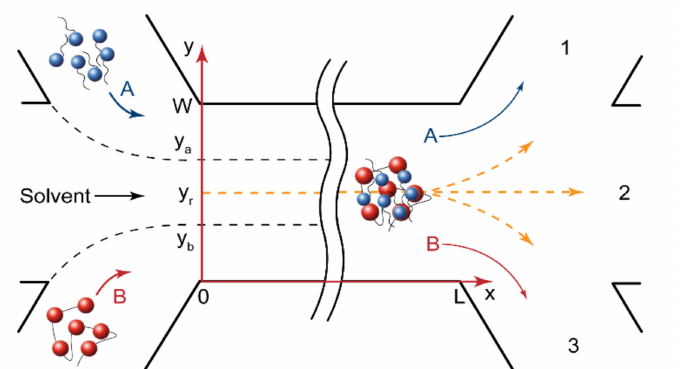
Figure 2. Geometry of microfluidic devices. The reagents were fed through the side input channels, the solvent was fed through the central input channel to avoid an immediate mixing of reagents and the start of reaction. The product formed at a distance from the junction of the input channels and then was distributed between output channels, depending on the reaction front